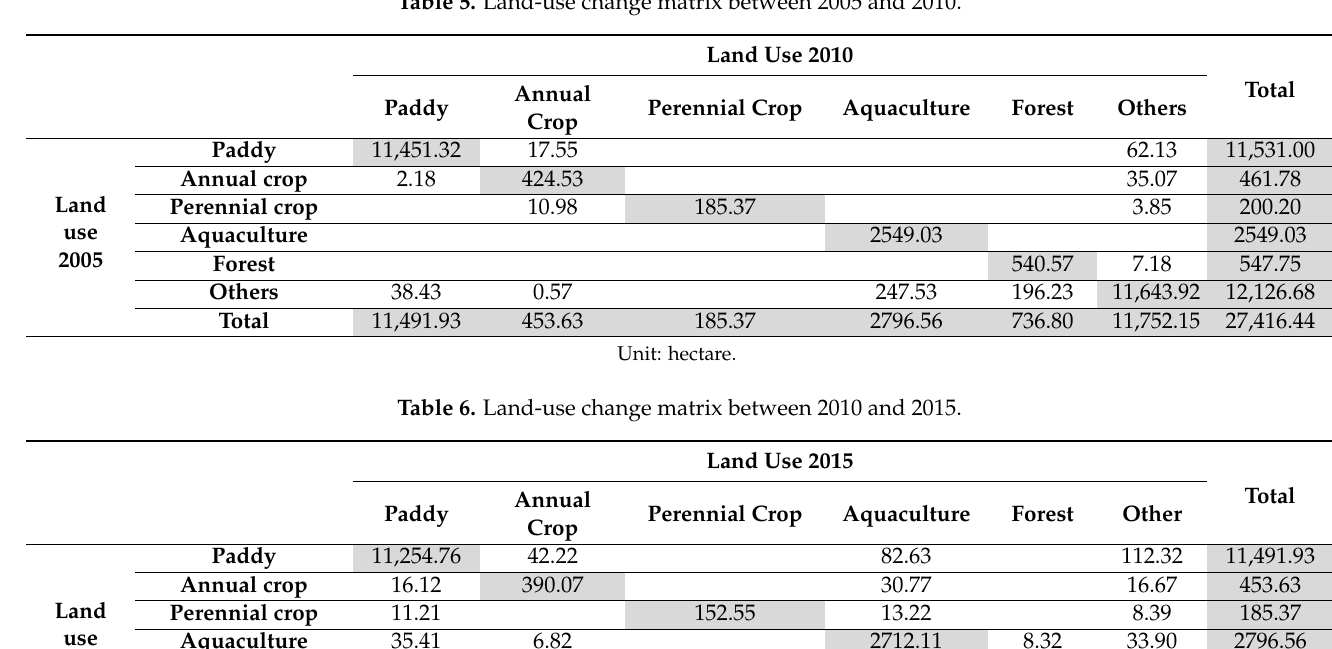
Table 5. Land-use change matrix between 2005 and 2010.